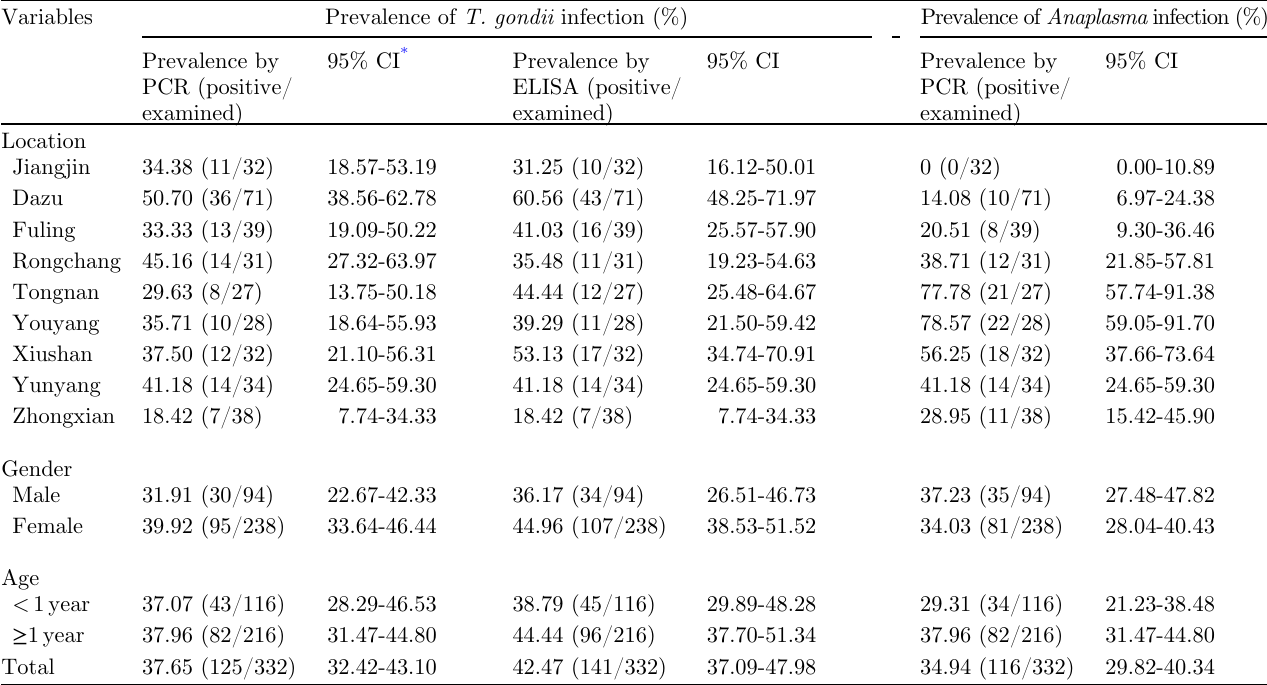
Table 2. Overall prevalence of T. gondii and Anaplasma infection in goats in Chongqing, southwest China tested by PCR and ELISA. Variables Prevalence of T. gondii infection